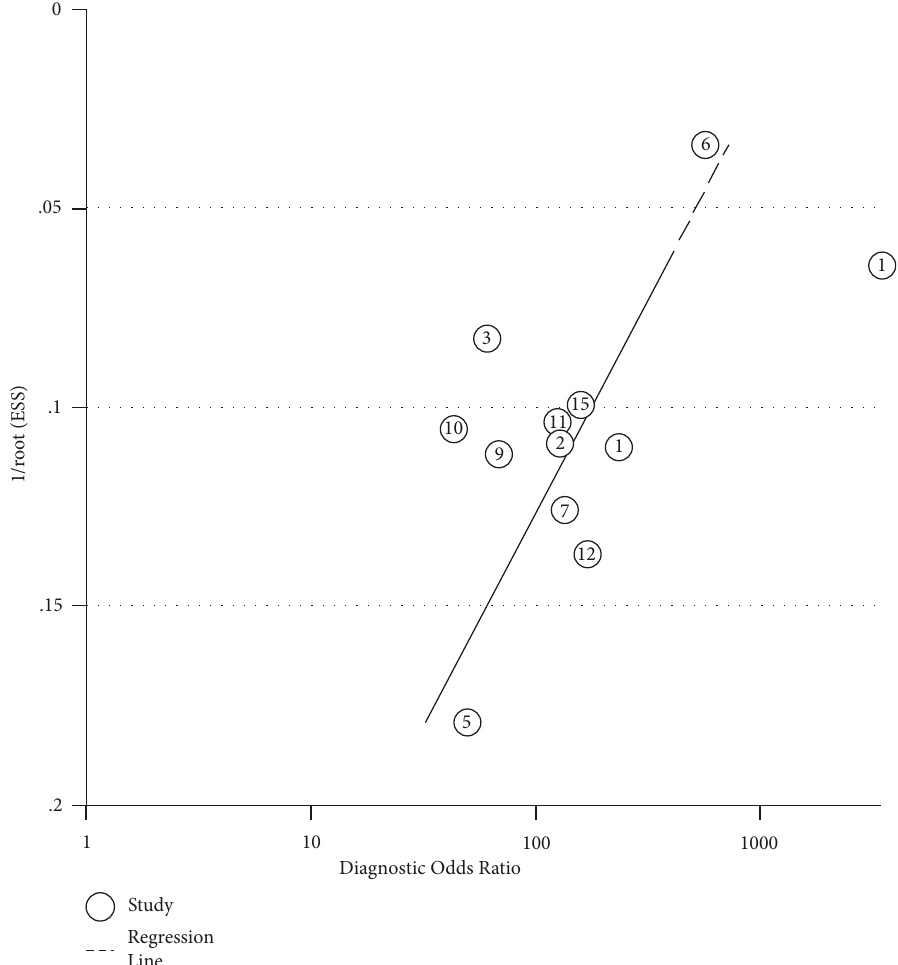
Figure 7: Deeks’s funnel plot. The apparent asymmetric shape of Deeks’s funnel plot and P value � 0.02 indicate that publication bias significantly existed in the